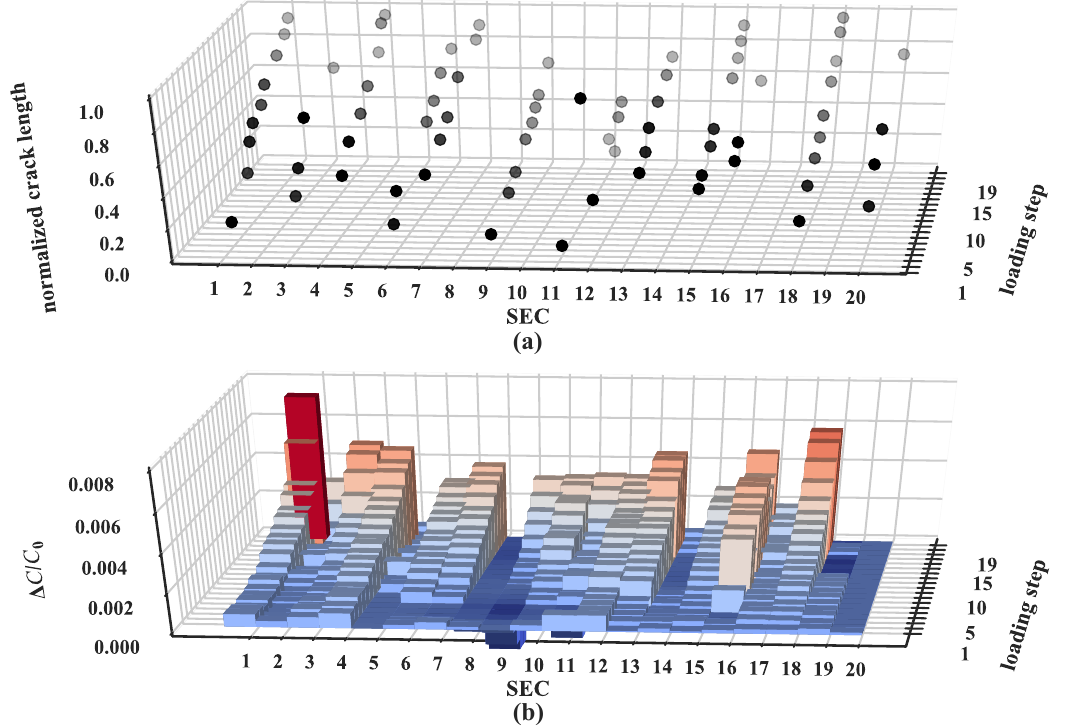
Figure 12. ( a ) Normalized crack length as a function of SEC location and loading step; ( b ) maximum relative change in capacitance change as a function of SEC location and loading